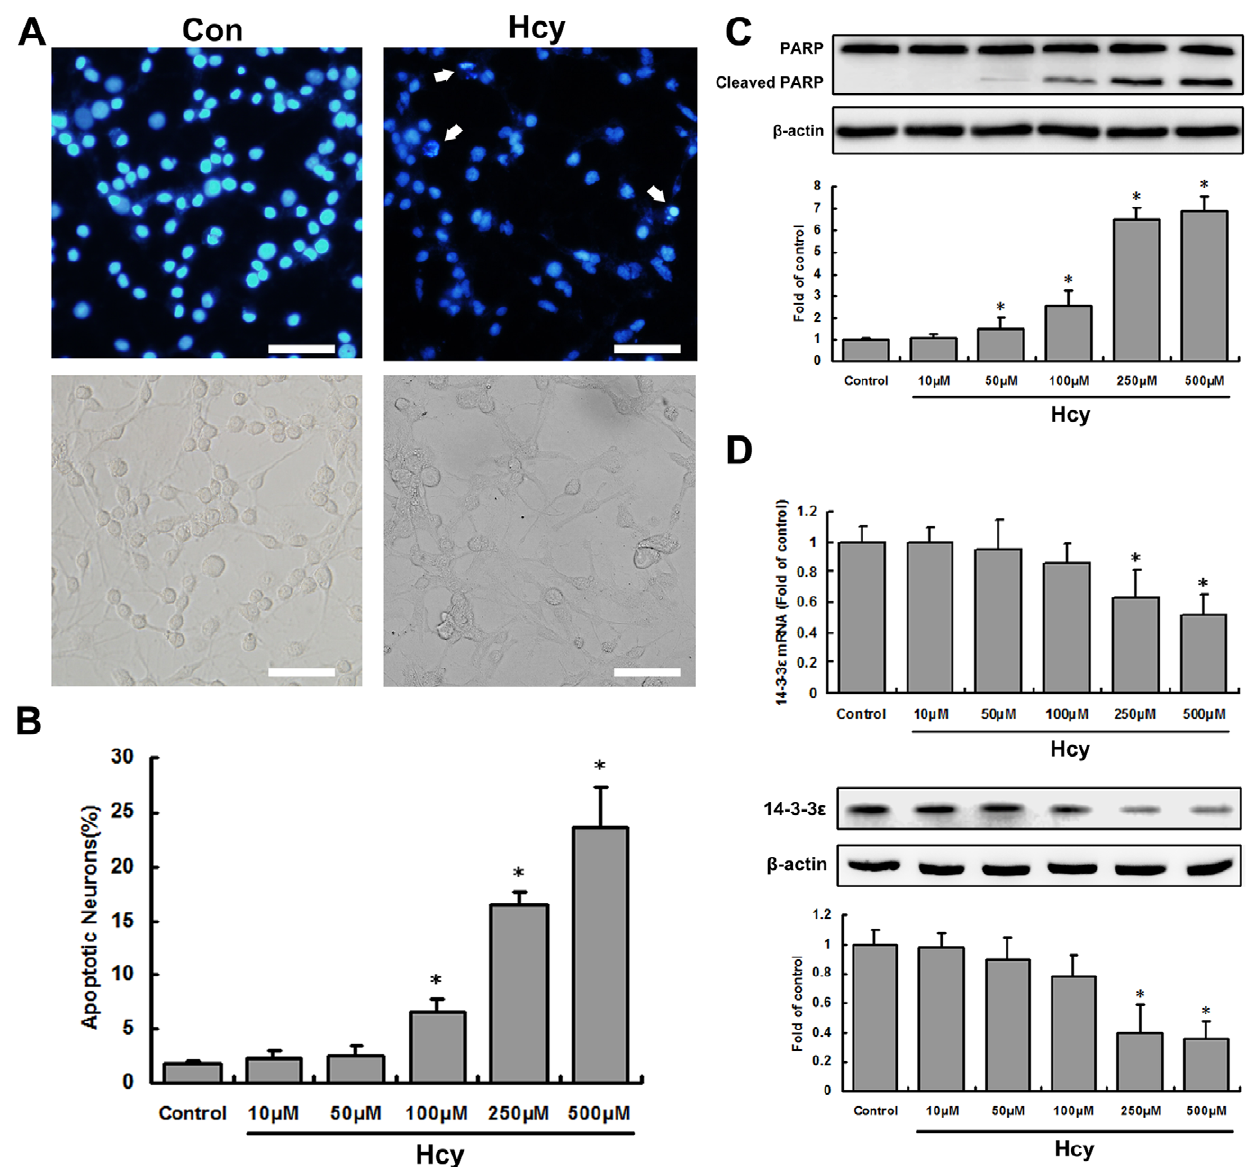
Figure 1. Hcy induces apoptosis and suppresses 14-3-3 e expression in cultured hippocampal neurons. A, Cultures were exposed for 24 h to either saline ( Con ) or 500 m M Hcy ( Hcy ) and were subsequently stained with the fluorescent DNA-binding dye Hoechst 33342 ( top ) or photographed under phase-contrast optics ( bottom ). Note the nuclear DNA condensation and fragmentation in neurons exposed to Hcy (arrow). Scale bar: 100 m m. B, Cultures were exposed to the indicated concentrations of Hcy for 24 h, and the percentages of neurons with apoptotic nuclei were quantified. Values are the mean 6 S.E.M. of counts made in four to six cultures. C, Cells were treated as in B, and the levels of cleaved PARP were determined by western blotting. Top, representative western blots. Bottom, densitometric analysis of cleaved PARP normalized by b -actin ( n =3). D, 14-3-3 e mRNA and protein was measured by real-time quantitative PCR ( top ) and western blotting ( mid and bottom ), respectively. * P , 0.05 vs. control.